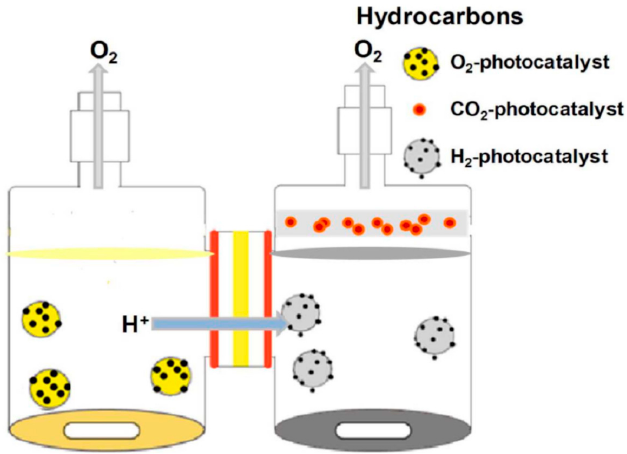
Figure 4. Illustration of twin reactor setup, reproduced with permission from reference [22]. Copyright